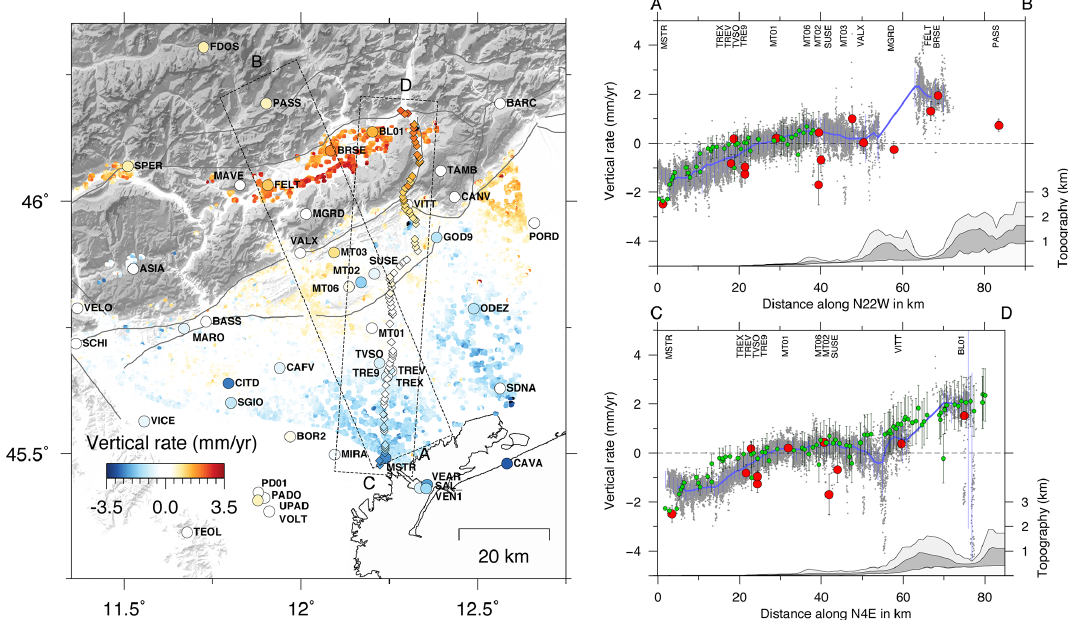
Figure 5. On the left, vertical velocity field from InSAR data decomposition (dots), from GPS measurements (circles) and from the IGMI leveling data (diamonds), in which blue colors indicate negative (subsidence) values and red colors indicate positive (uplift) values. On the right, cross sections of vertical velocities along the A–B (top) and the C–D (bottom) profile. The blue lines and red circles are the same as in Fig.